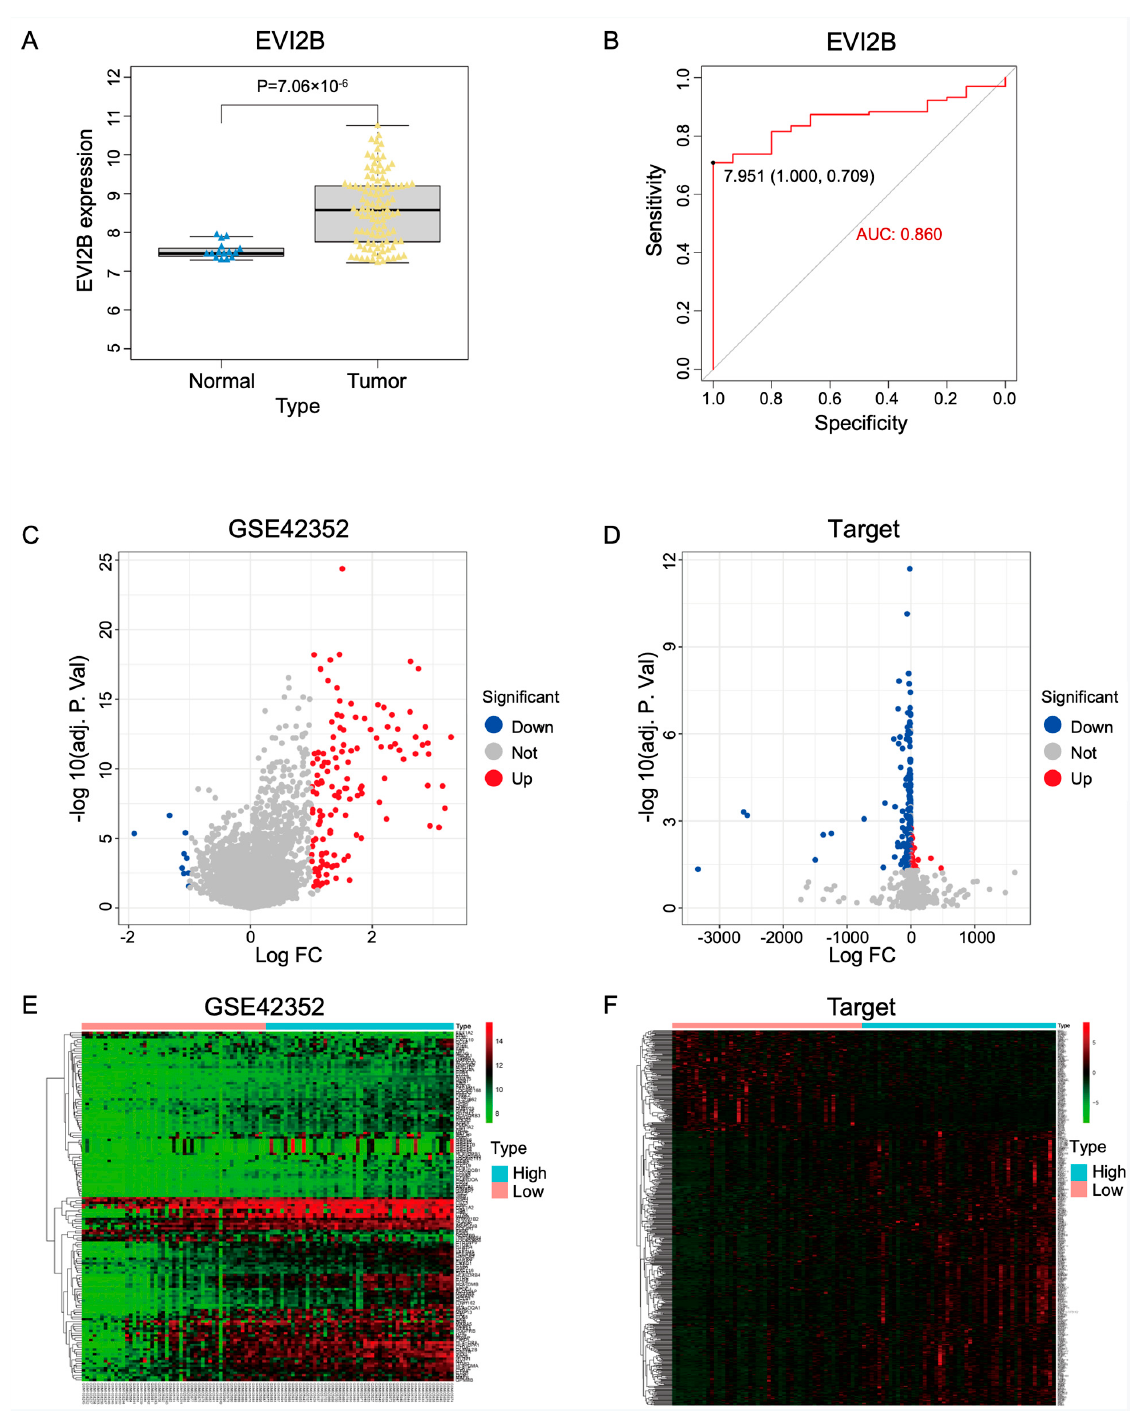
Figure 1. Analysis of EVI2B and DEGs ( A ) EVI2B expression was significantly lower in tumor tissues than in normal tissues. ( B ) The area under ROC curve (AUC) for EVI2B in the test set was used to evaluate its diagnostic performance for osteosarcoma. ( C ) The GSE42352 dataset (test set) was divided into high- and low-expression groups according to the median expression of EVI2B . Significant DEGs between groups are shown in a volcano plot. ( D ) The Target − OS dataset (validation set) was divided into high- and low-expression groups according to the median expression of EVI2B . Significant DEGs between groups are shown in a volcano plot. ( E ) DEGs between high- and low- EVI2B -expression groups in the GSE42352 dataset are presented in a heat map. ( F ) DEGs between high- and low- EVI2B -expression groups in the Target − OS dataset are presented in a heat